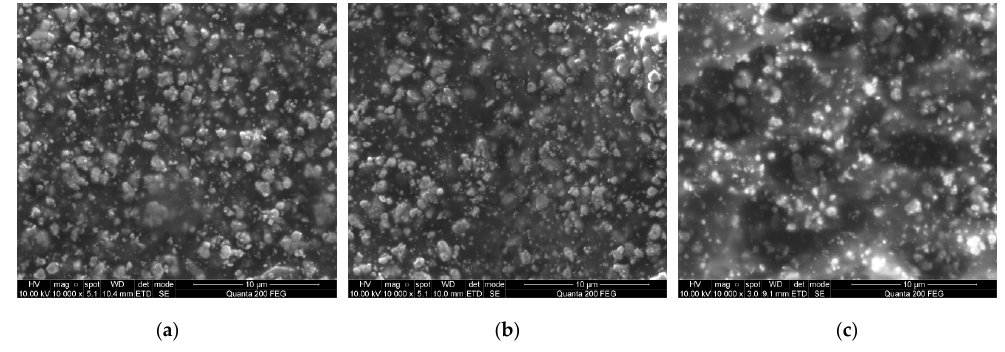
Figure 6. SEM views of samples: ( a ) Element 1 (mesh 32/70); ( b ) Element 2 (mesh 48/70); ( c ) Element 3 (mesh 140/34).